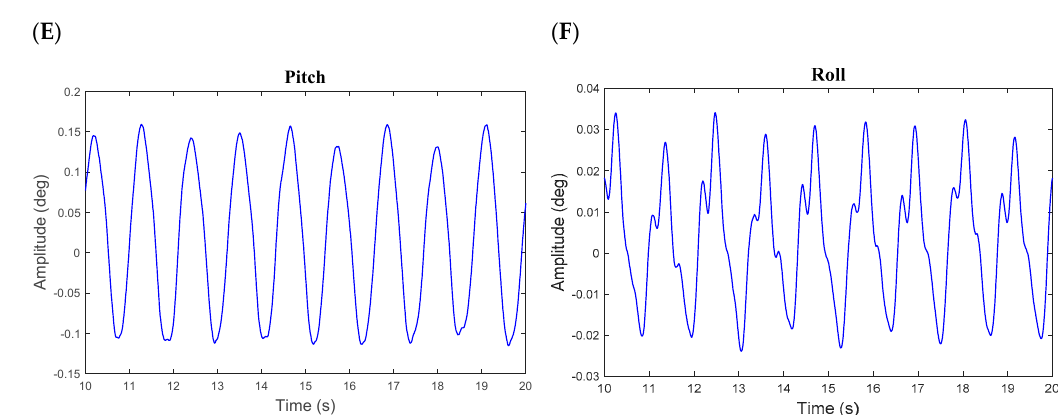
Figure 11. Time history of model motions recorded for condition 3: surge motion ( A ), sway motion ( B ), heave motion ( C ), yaw motion ( D ), pitch motion ( E ) and roll motion ( F ).